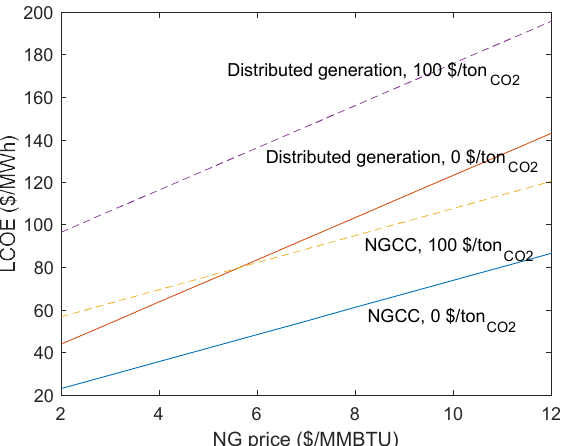
Figure 6. The levelized costs of electricity (LCOE) for two types of NG-fired generation as a function of NG price and carbon tax. Calculations are based on the assumptions from the EIA’s 2021 Annual Energy Outlook.